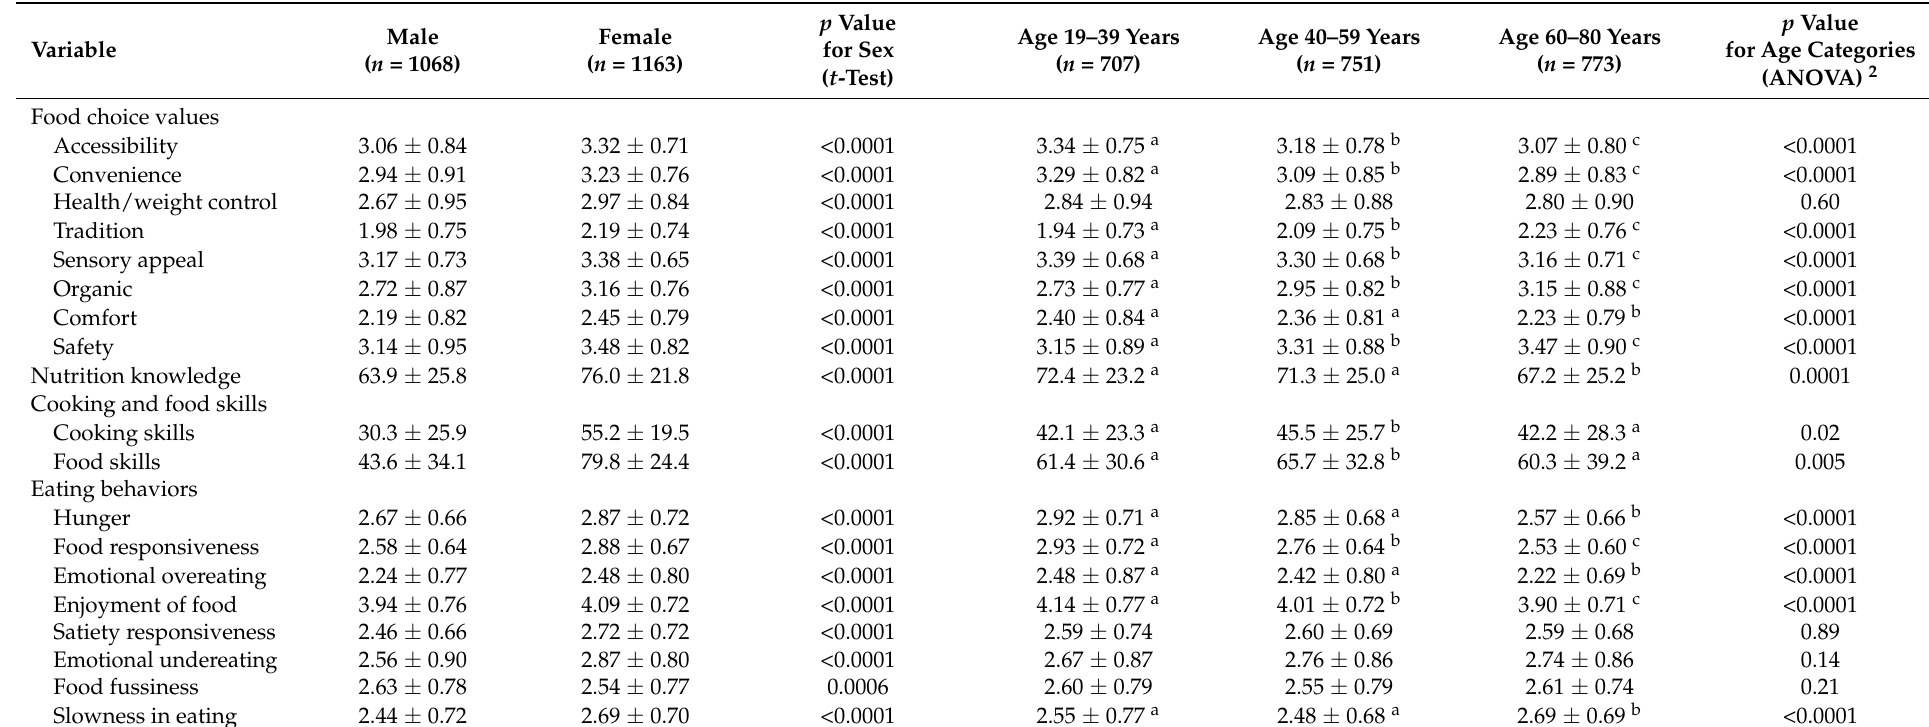
Table 3. Food choice values and food literacy variables characterized by nutrition knowledge, cooking and food skills, and eating behaviors according to sex and age categories ( n = 2231) 1